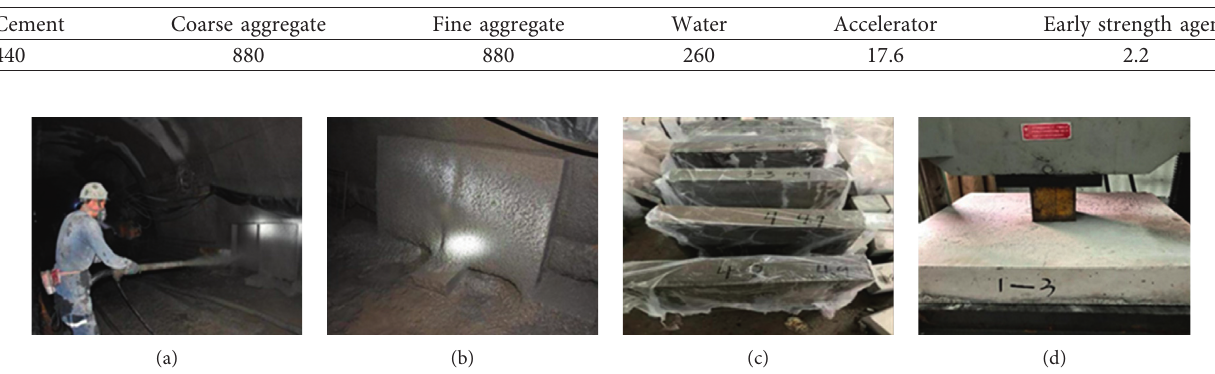
Table2: Shotcrete mix of experimental specimens (kg/m 3 ).